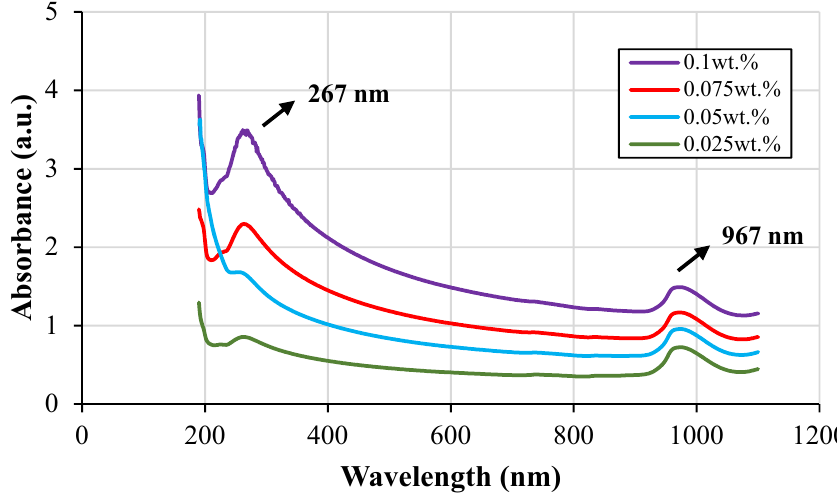
Figure 3. UV-Visible spectroscopy of CF-GNPs-H 2 O nanofluids with various nanoparticle concen- trations.